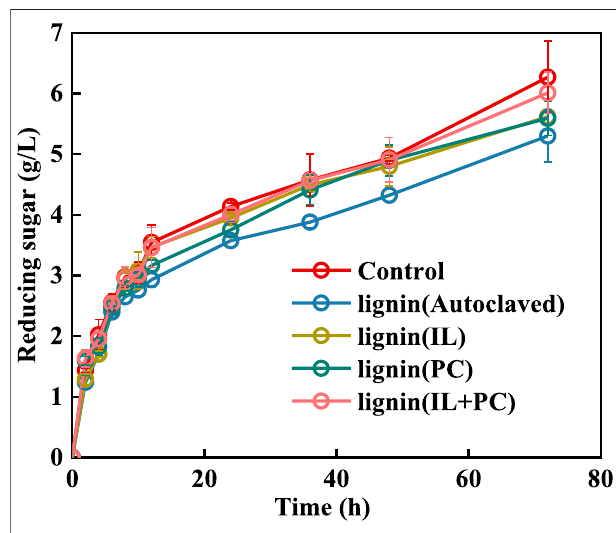
FIGURE 7 | Effects of fungi-treated lignin on reducing sugar yield in the enzymatic sacchari fi cation of Avicel.